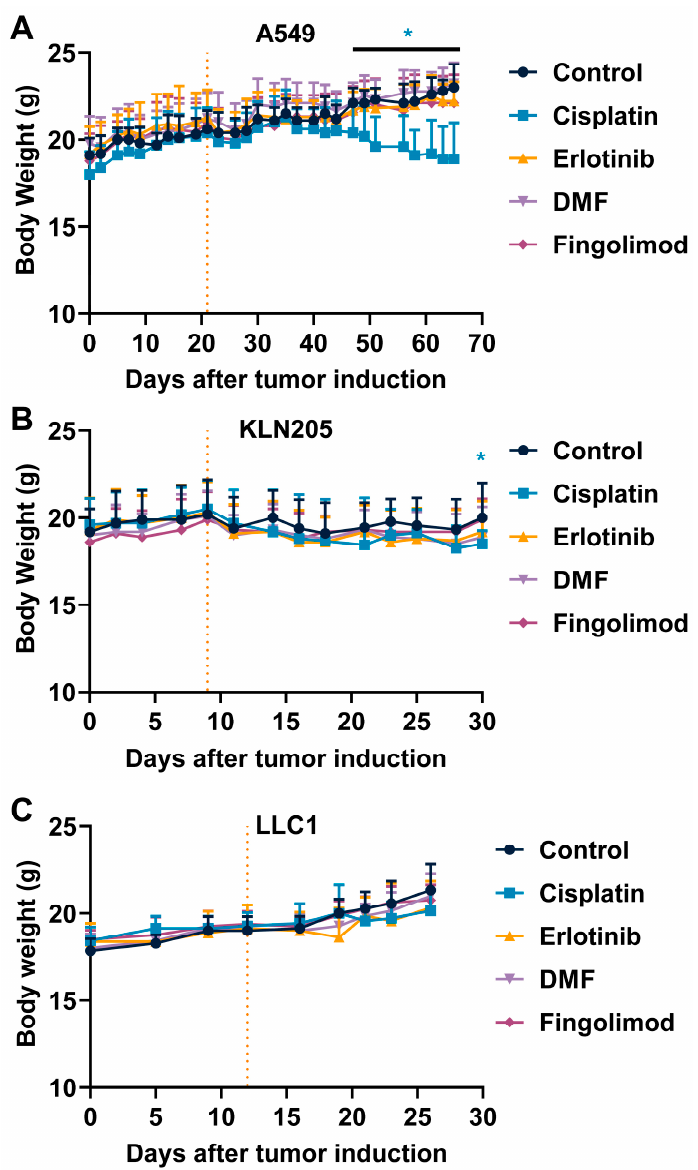
Figure 3. Effects of treatments on tumor-bearing mouse body weight. ( A – C ) Measure and comparison of mouse body weight upon Cisplatin at 1 mg/kg administrated 5 times a week (i.p.), Erlotinib at 50 mg/kg administrated 5 times a week (p.o.), DMF Erlotinib at 30 mg/kg administrated 5 times a week (p.o.), and Fingolimod Erlotinib at 5 mg/kg administrated 5 times a week (p.o.) on tumor volume in A549 xenograft ( A ), KLN205 syngeneic ( B ), and LLC1 syngeneic ( C ) mouse models. Discontinuous orange line highlights the treatment beginning. Statistical differences between the groups were determined using a mixed-effects model (REML, groups, and time as a factor) followed by Tukey’s multiple comparisons test (vs. control, * p ≤ 0.05). Data represent mean and SD. n = 9–10 mice per group at the start of